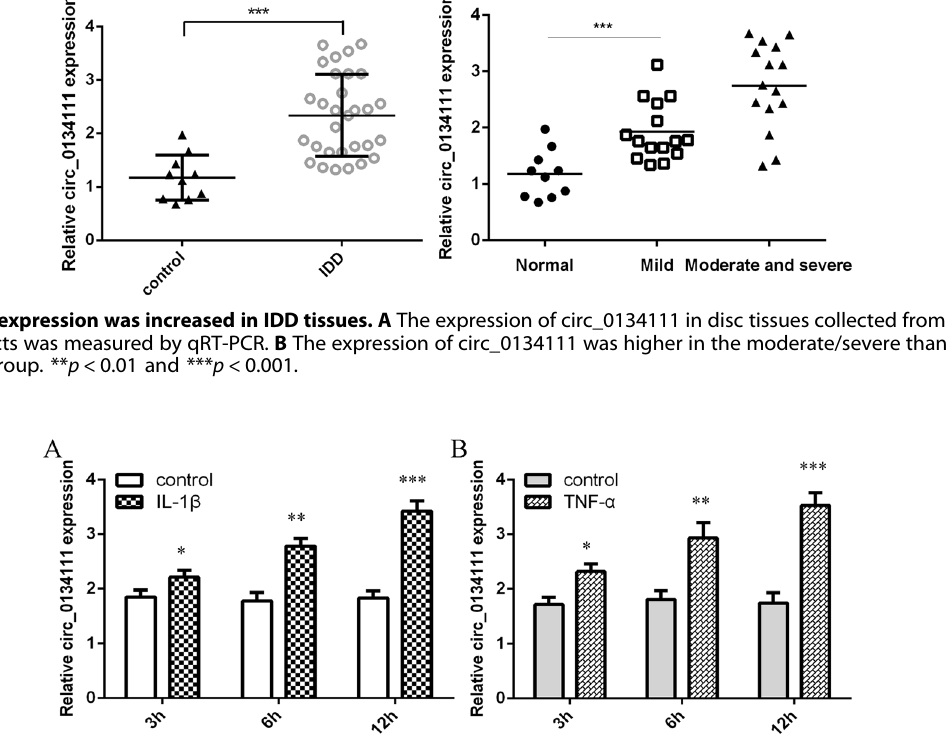
Fig. 2 IL-1 β and TNF- α induced circ_0134111 expression in NP cells. A IL-1 β signi fi cantly increased circ_0134111 expression in NP cells. B The expression of circ_0134111 in NP cells after incubation with TNF- α . * p < 0.05, ** p < 0.01, and *** p <